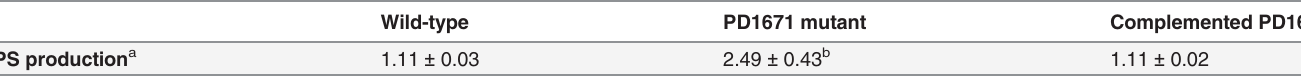
Table 4. Relative X . fastidiosa exopolysaccharide (EPS) production.